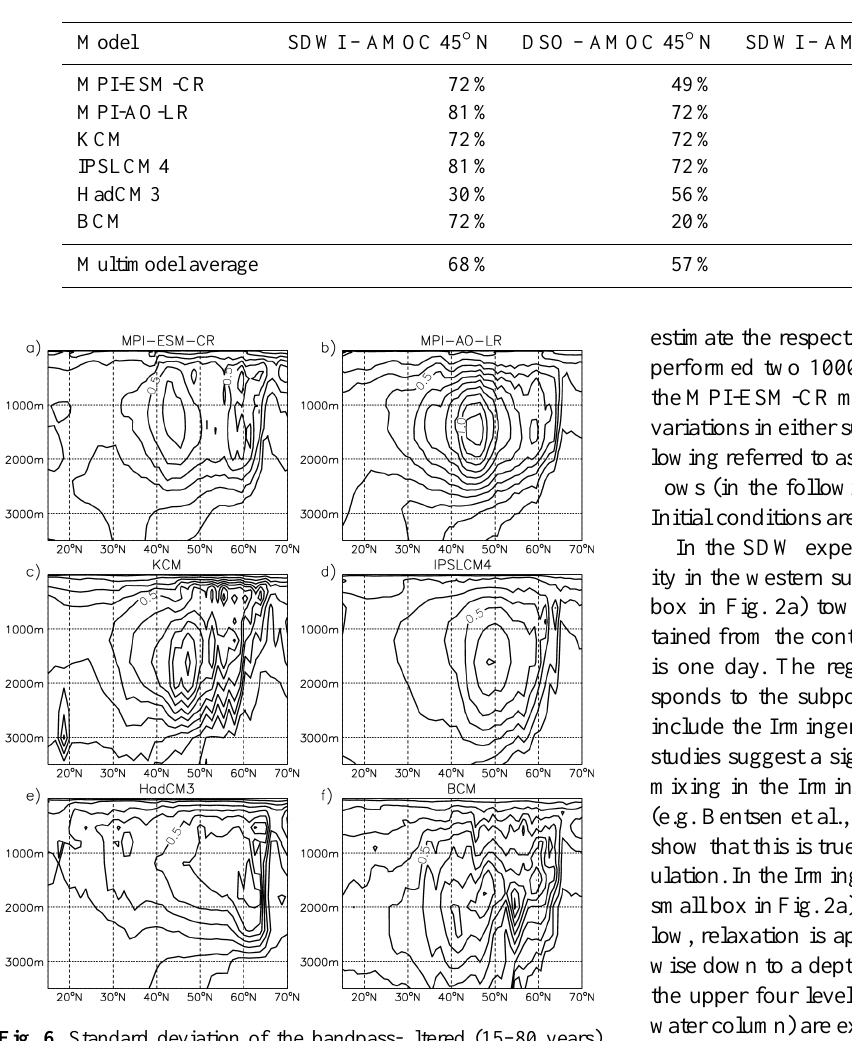
Fig. 6. Standard deviation of the bandpass-filtered (15–80 years) Atlantic meridional overturning streamfunction (in Sv) in the con- trol simulation with (a) MPI-ESM-CR, (b) MPI-AO-LR, (c) KCM, (d) IPSLCM4, (e) HadCM3 and (f) BCM. Contour interval is 0.1Sv, starting from